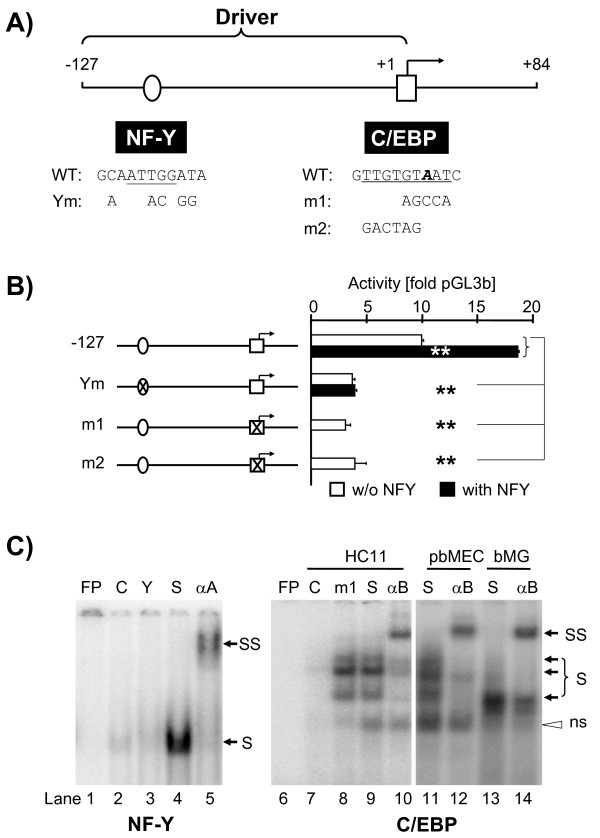
Binding of NF-Y and C/EBP factors to the proximal PIA drives activity. (A) Map and sequences of the NF-Y and C/EBP binding sites on the proximal PIA. Core motifs (underlined) of the respective binding sequences and mutations are shown, as they have been included in EMSA and reporter gene analyses. The tsp in the C/EBP motif (“A” nucleotide, bold, italicized) is indicated. (B) Mutation of the binding sites of NF-Y (Ym) as well as of C/EBP (m1, m2) significantly reduce the reporter genes activity (open columns). Joint co-transfection of expression constructs for all three NF-Y factors (NF-YA -B, -C) significantly increase activity of WT-promoter, but not of the construct Ym. Mean values (+ S.E.M.) from one out of three experiments (Ym) or six independent experiments (C/EBP mutation), always assayed in triplicate and normalized against the WT construct. (C) EMSA analyses of the proximal NF-Y and C/EBP binding sites. Left: Nuclear extracts from HEK293 cells over-expressing jointly the factors NF-YA, -B, -C were incubated with the probe harboring the proximal NF-Y binding site (pNF_WT, Additional file 1: Table S4). The shifted band (S) was supershifted (SS) by anti-NF-YA antibodies (αA). Right: The labeled probe was the proximal C/EBP site (pCE_WT, Additional file 1: Table S4). Multiple specific shift bands (S) appeared with nuclear extracts from HC-11 cells, pbMEC, or bMG. Anti-C/EBP antibodies (αB) caused supershifts (SS). Lane designations are similar to Figure 2C and D; m1, competition with 100-fold molar excess of unlabeled probe, mutated as shown in Figure 3A. “ns” represents a non-specific band.